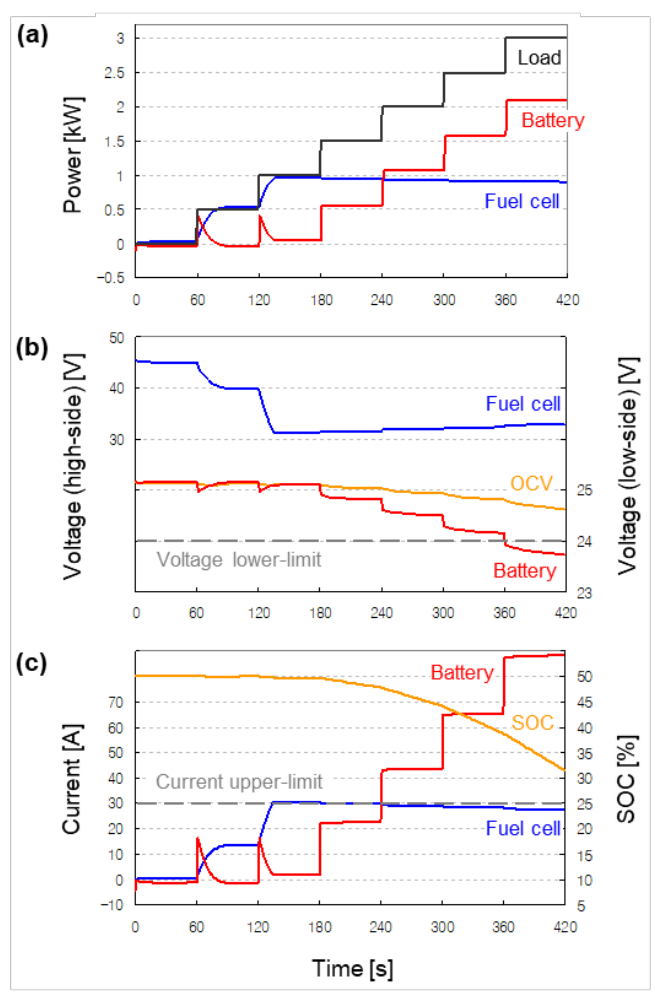
Figure 10. Simulated ( a ) power, ( b ) voltage, and ( c ) current with SOC of HPS under the overload condition.